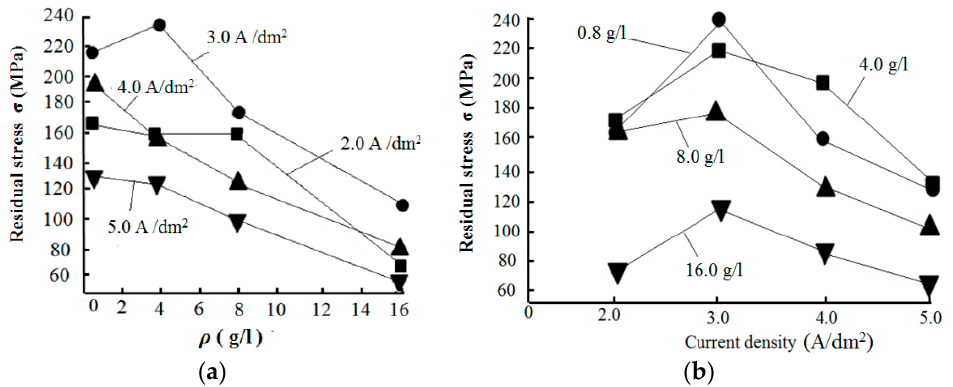
Figure 14. Effect of ( a ) nanodiamond concentration in the plating solution and ( b ) current density on the residual stress of the composite coating.